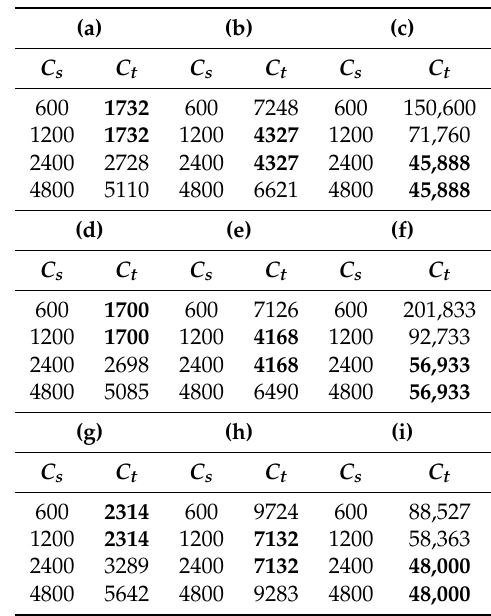
Table 8. Total cost C t = C s + β · T min ( C s ) as a function of C s and different values of β . First row, from left to right: β = 18.12 ( a ), 106.38 ( b ), and 2400 ( c ) for half E glob . Second row: β = 18.23 ( d ), 108.10 ( e ), and 3333 ( f